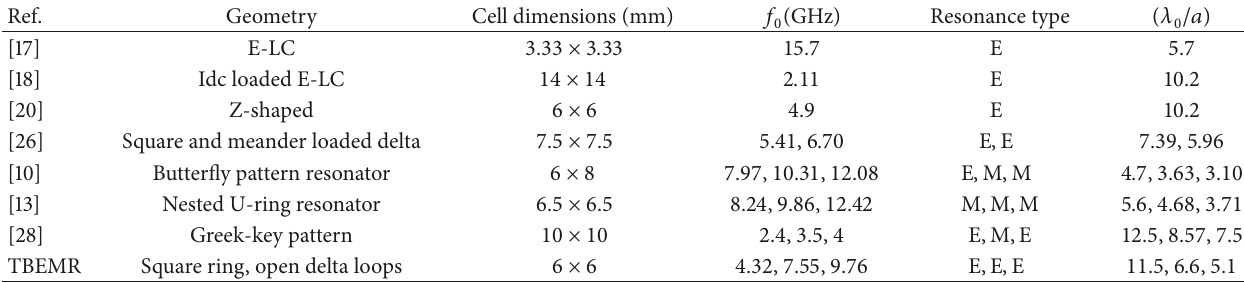
Table 3: Performance comparison with reported single negative SNG ( 𝜀 < 0 and/or 𝜇 < 0 ) metamaterial resonators from the literature.